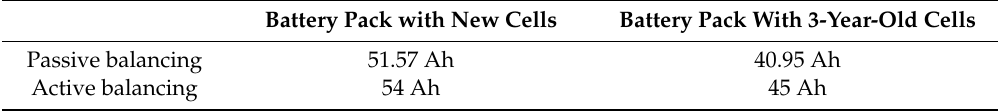
Table 1. Useful capacities at the BoL and after 3 years with the passive and active balancing